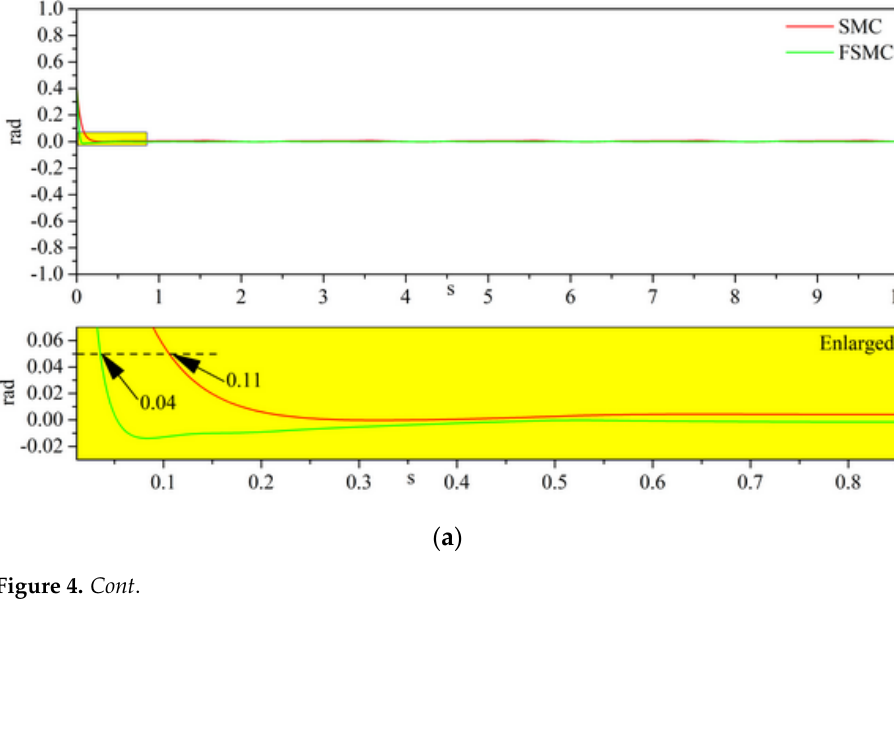
Table 1. maximum errors (rad) at steady state.